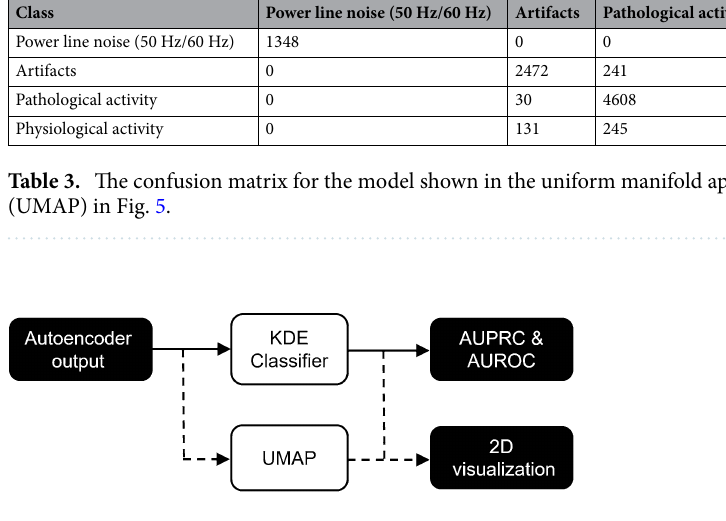
Figure 6. Figure shows pipeline for model inference and uniform manifold approximation and projection (UMAP) visualization of an output autoencoder